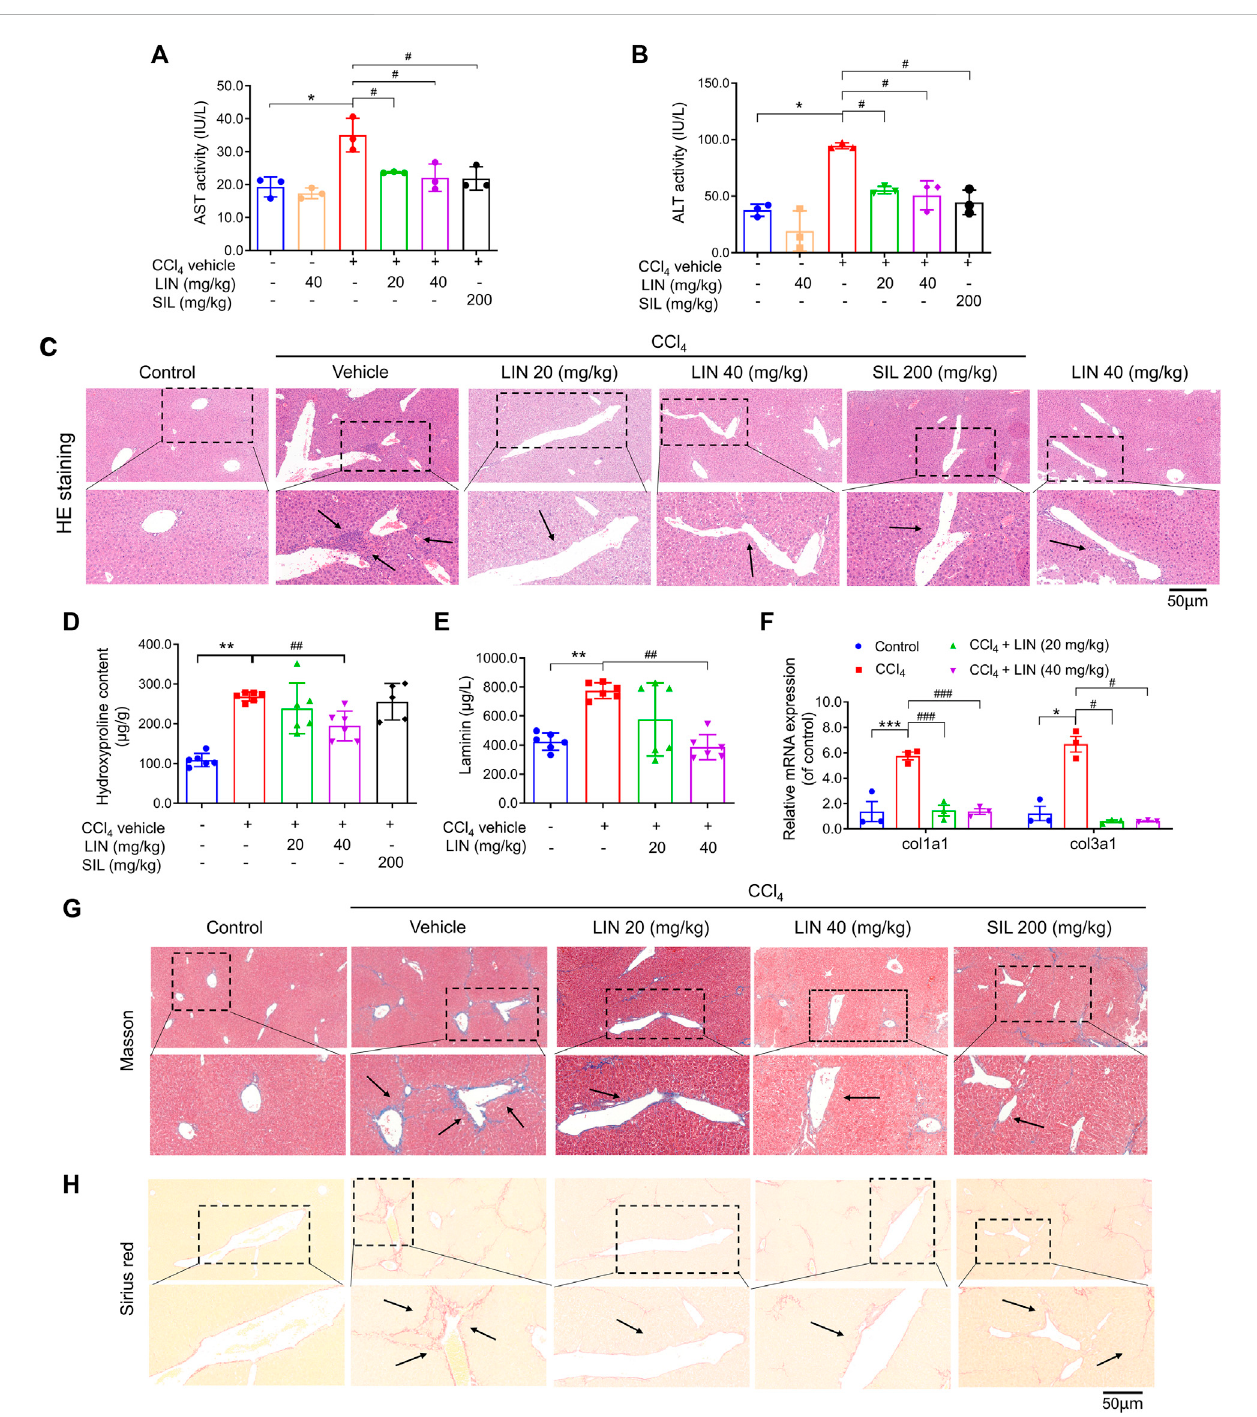
FIGURE 3 LIN attenuated CCl 4 -induced hepatic injury and fi brosis in mice. (A) AST activity. (B) ALT activity. (C) Liver H&E staining. Representative images were chosen from each experimental group. (Upper images: original magni fi cation × 200; Lower images: partially enlarged pictures). Data were expressed as means ± SEM ( n = 3). *p < 0.05 vs. control group; # p < 0.05 vs. CCl 4 group. (D) Liver hydroxyproline content ( n = 5 – 7). (E) Hepatic Col1a1 (Collagen, type I, α 1) andCol3a1(Collagen,typeIII, α 1)( n =3). (F) Serumcontentsoflaminin( n =7). (G) LiverMasson ’ strichromestaining.Representativeimages werechosen from each experimental group. (Upper images: original magni fi cation × 200; Lower images: partially enlarged pictures). (H) Liver Sirius red staining. Representative images were chosen from each experimental group. (Upper images: original magni fi cation × 200; Lower images: partially enlarged pictures). Data were expressed as means ± SEM. *p < 0.05, * *p < 0.01, ** *p < 0.001 vs. control group; # p < 0.05, ## p < 0.01, # ## p < 0.001 vs. CCl 4